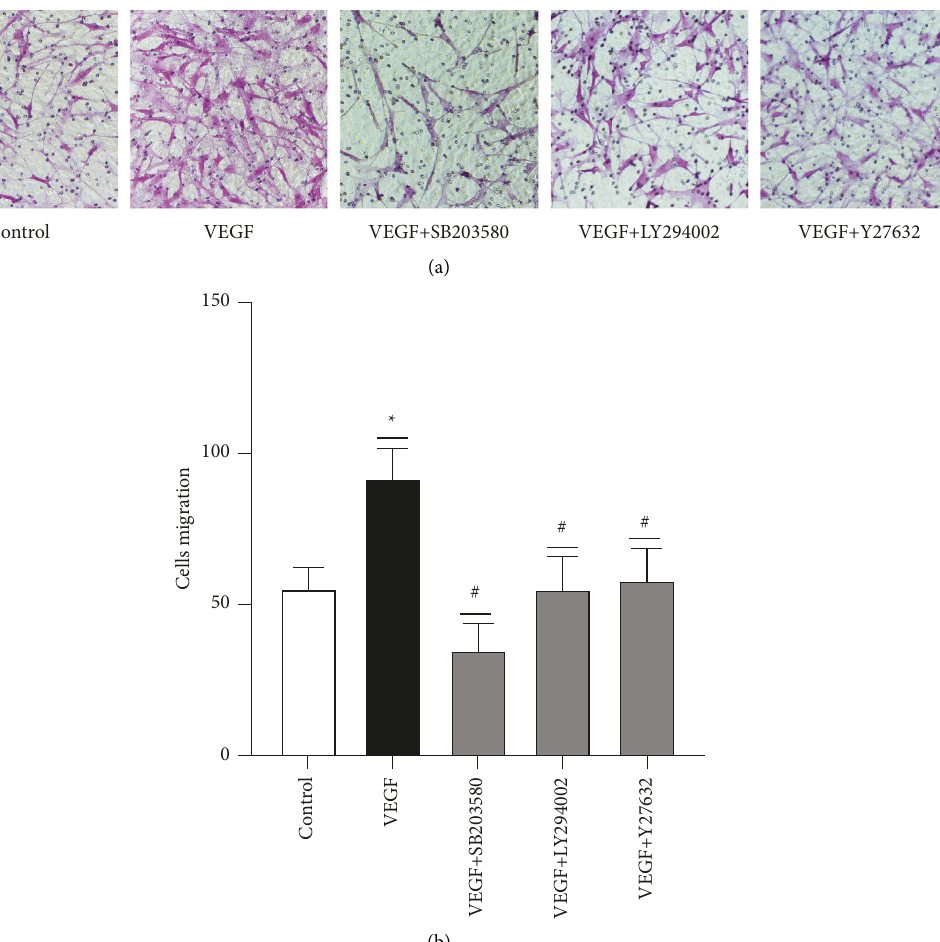
Figure 6: Effect of signaling pathway inhibitors on VEGF-induced ASMC migration. (a) A representative image of cell migration. (b) The histogram shows the number of migrating cells in each group, and the data are expressed as the mean ± standard deviation (M ± SD). ∗ P < 0 . 05. # There are significant differences between the VEGF+SB203580 group, VEGF+LY294002 group, and VEGF+Y27632 group and VEGF group ( P < 0 .